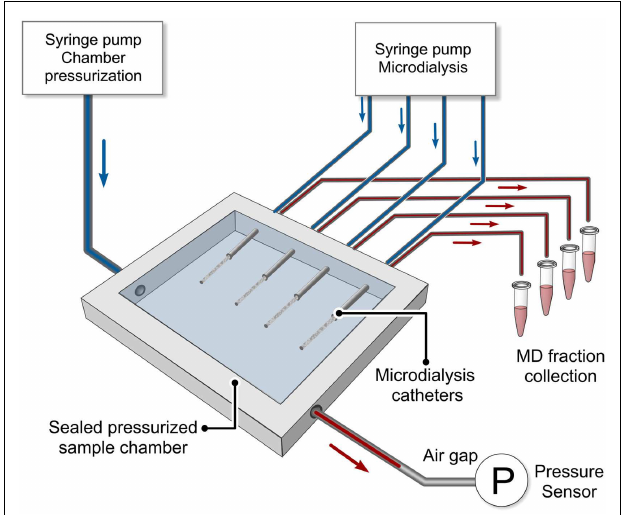
FIGURE 1 | Schematic drawing of a pressurized in vitro MD sampling system is shown .The chamber held four MD catheters and was used to study the impact of different pressures present in a MD sampling system on fluid recovery (42). Pressure parameters tested included perfusion flow rate, colloid osmotic additives in both perfusate and sample, and static outside pressure.The precision of the system was <0.5mmHg and pressures could be set accurately in order to simulate different NIC conditions [adopted from Ref. (42)].